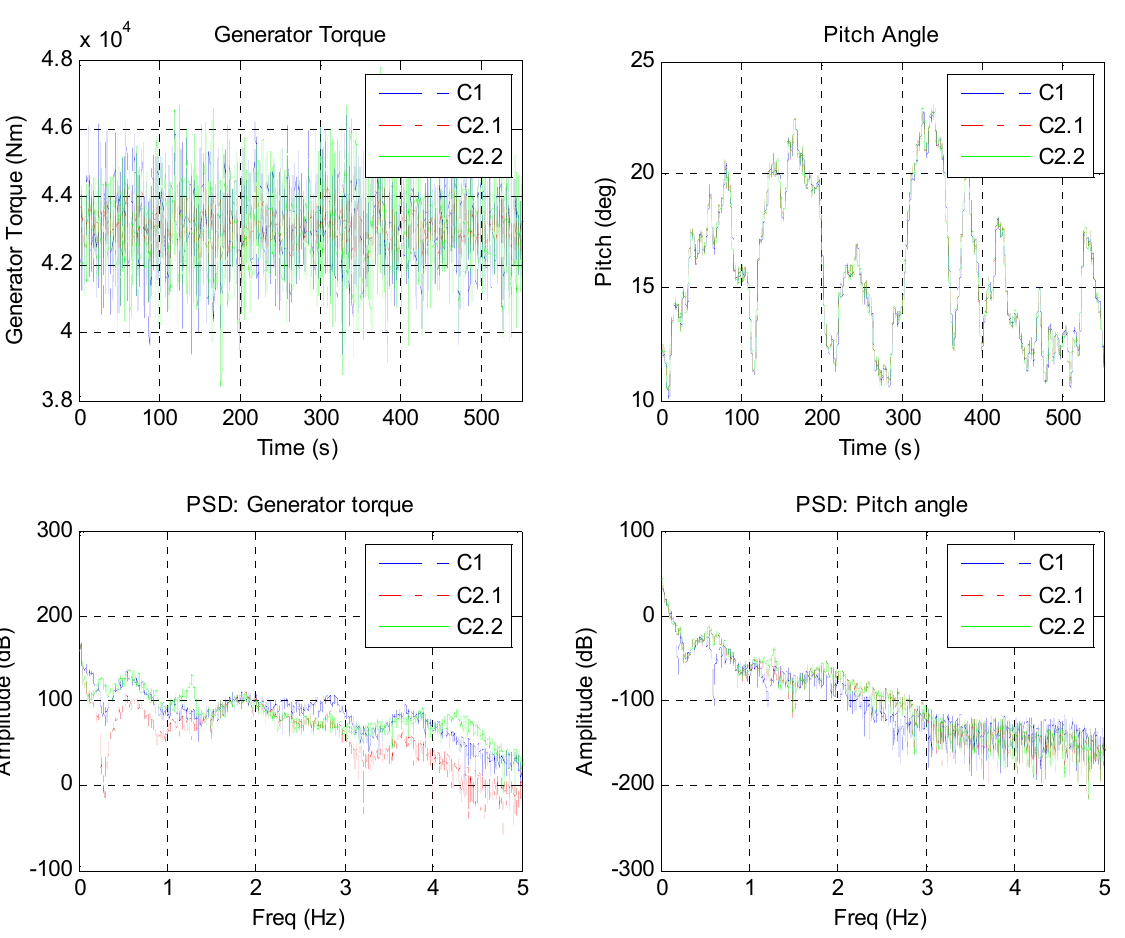
Figure 18. Generator torque and pitch angle with a turbulent production wind of 19